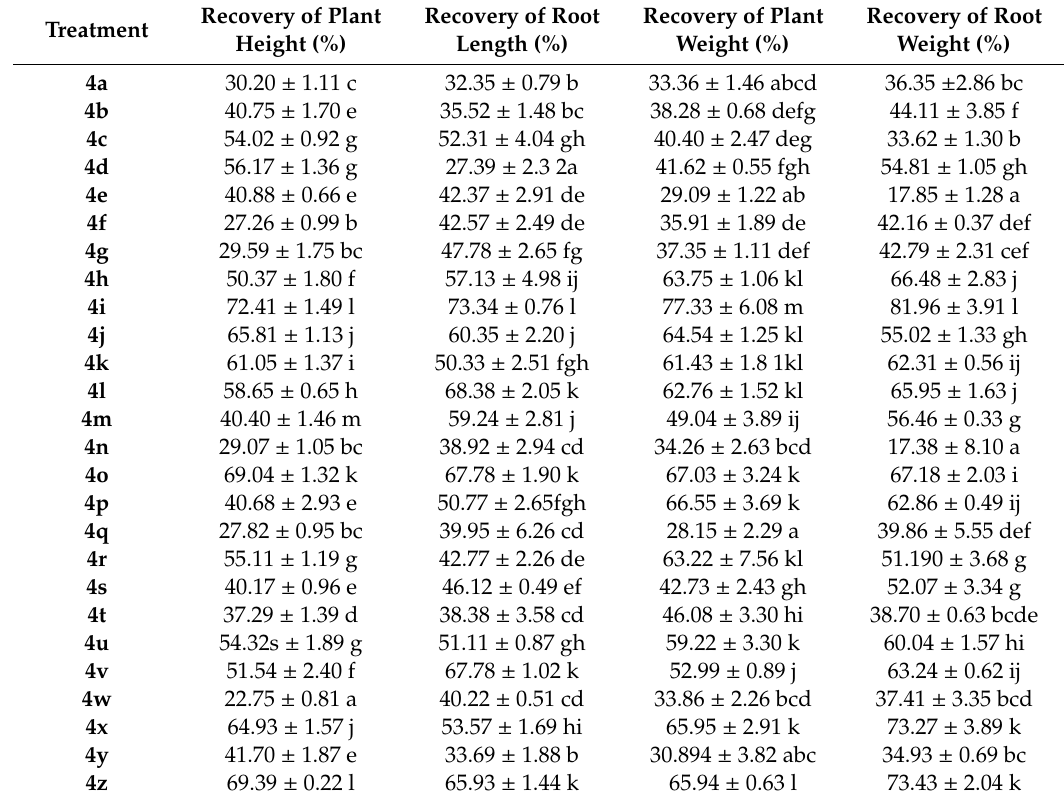
Table 2. E ff ect of safener concentration on maize growth indicator recovery rates I,II,III